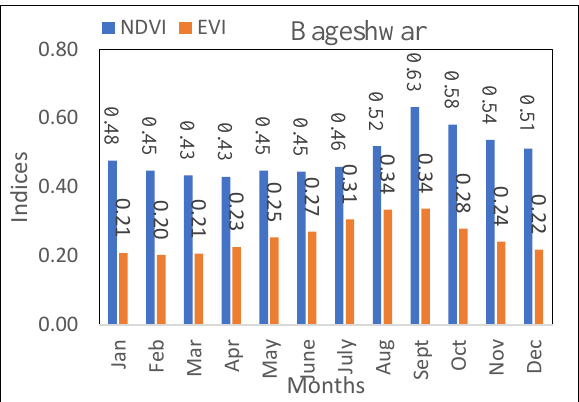
Figure 3. Nainital District Vegetation Cover (NDVI and EVI values)